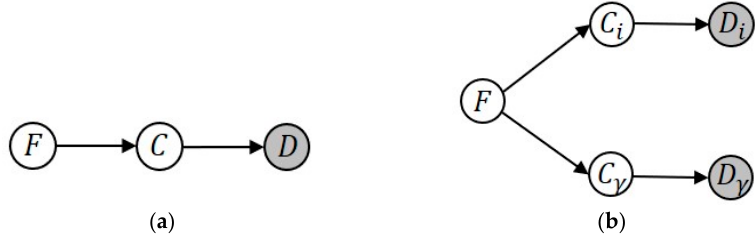
Figure 1. The Bayesian network structure for flood mapping. The variable F indicates flood states, C is a hidden variable, and D is a variable of observed Synthetic Aperture Radar (SAR) data. The subscript 𝑖 and 𝛾 indicate intensity and coherence, respectively: ( a ) The original Bayesian network; ( b ) Bayesian network with decoupled variables C and D .